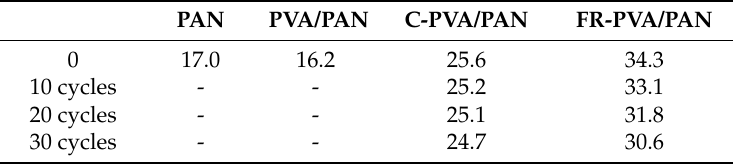
Table 4. Limiting oxygen index (LOI) values (%) of different fabrics before and after washing.